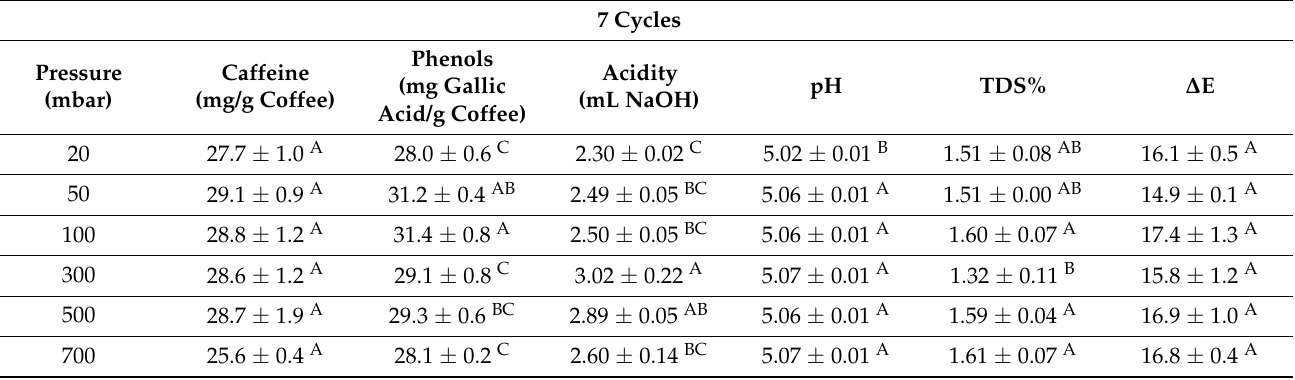
Table 5. Effect of pressure on physicochemical properties for 7 vacuum cycles (avg ± SD, n = 3) 1,2 . 7